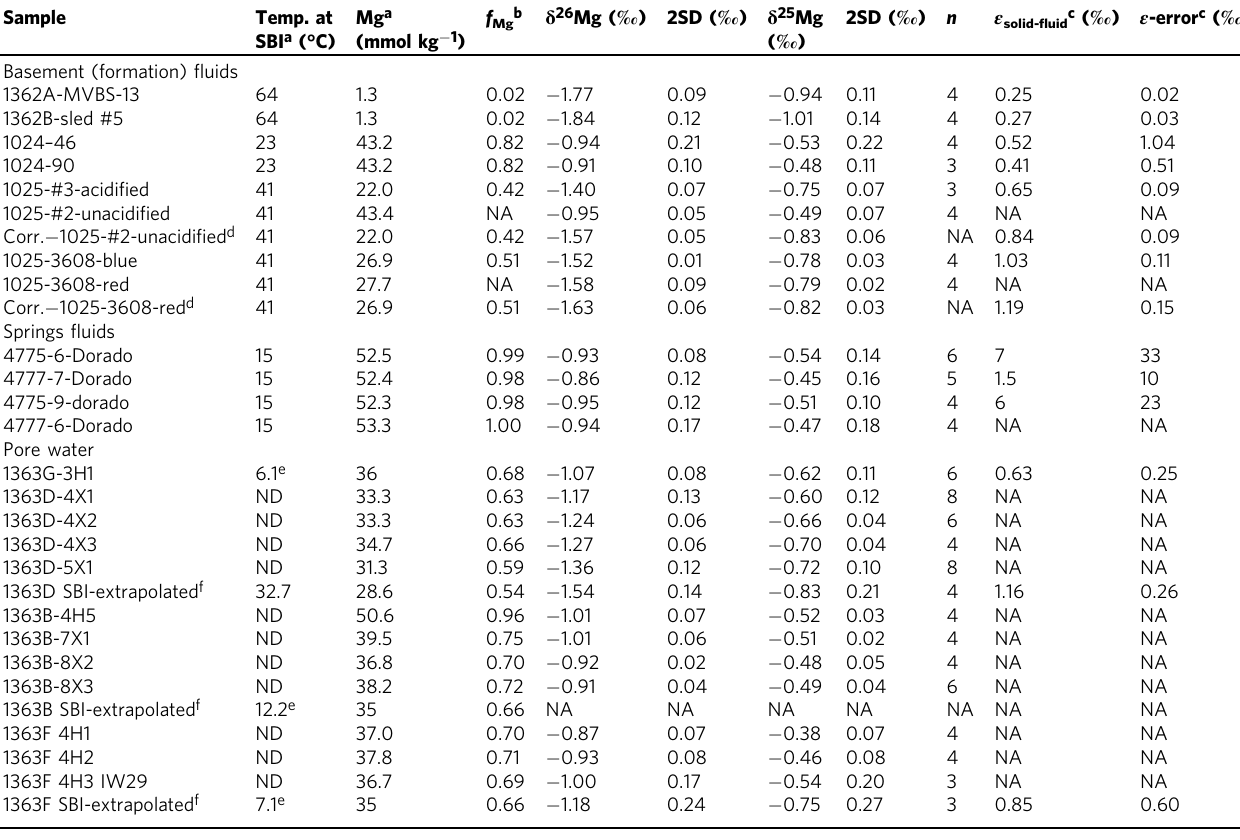
Table 1 Mg isotope values of the LTH fl uids.